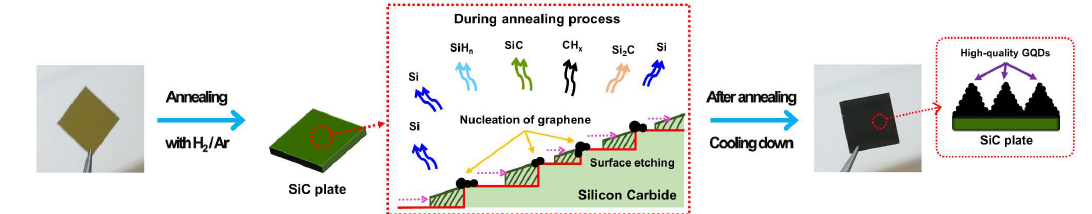
Figure 1. The schematic layout of the synthesis of high-quality graphene quantum dots (GQDs) by the hydrogen-assisted pyrolysis of silicon carbide (SiC).